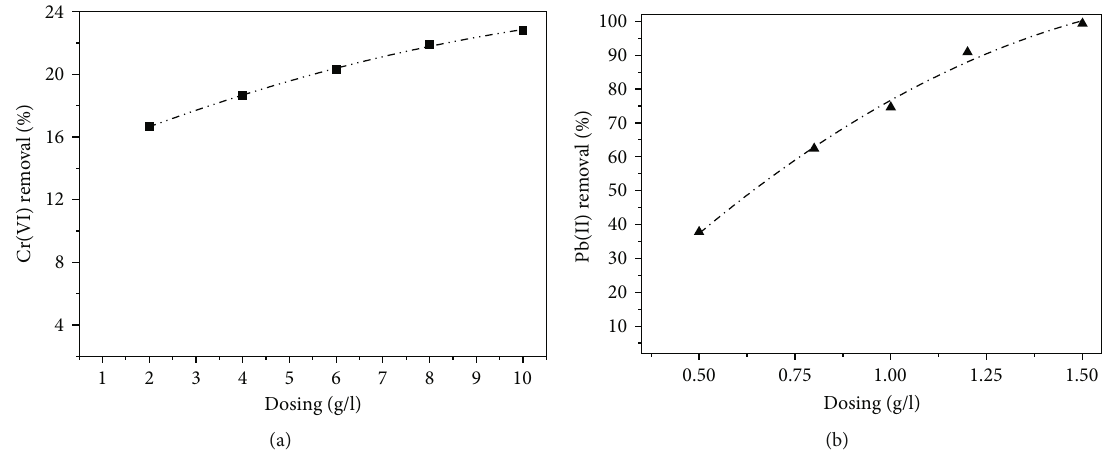
Figure 4: E ff ect of adsorbent dosing on the removal of (a) Cr(VI) and (b) Pb(II) from aqueous solution by using RHA-based zeolite